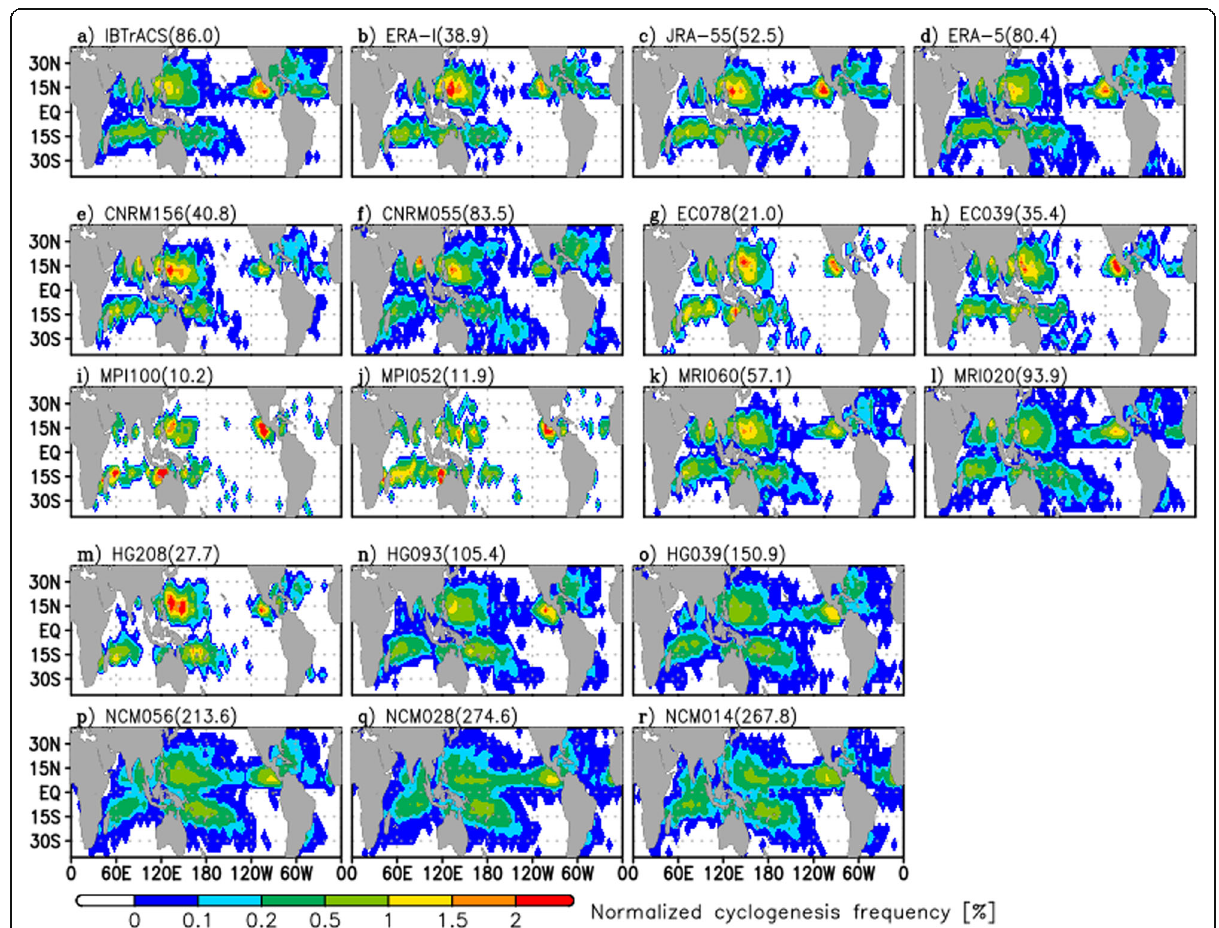
Fig. 1 Horizontal distributions of normalized TC genesis density. Panels show TC genesis densities of best track, reanalyses, and HighResMIP models: a IBTrACS, b ERA-I, c JRA-55, d ERA-5, e CNRM156, j CNRM055, g EC078, h EC039, i MPI100, j MPI052, k MRI060, l MRI020, m HG208, n HG093, o HG039, p NCM056, q NCM028, and r NCM014. Analysis periods are from 1990 to 2014 for panels a – q , and from 2000 to 2009 for panel r . The numbers in parentheses are the annual mean TC genesis frequencies during the respective analysis period for best track, reanalyses, and each model. Genesis density was defined as the number of TCs per year generated in a 5°×5° grid box. The genesis densities are normalized by the respective annual mean TC genesis